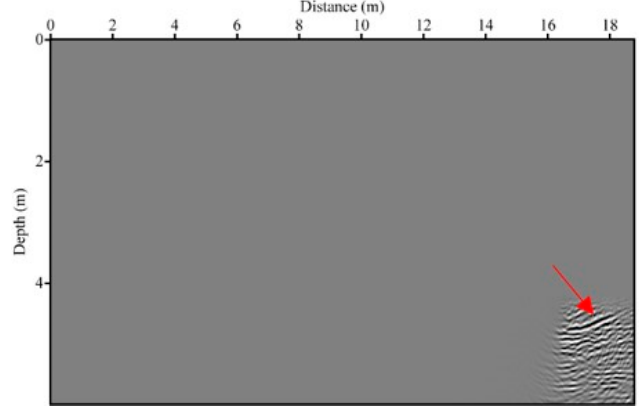
Figure 16. PP imaging based on